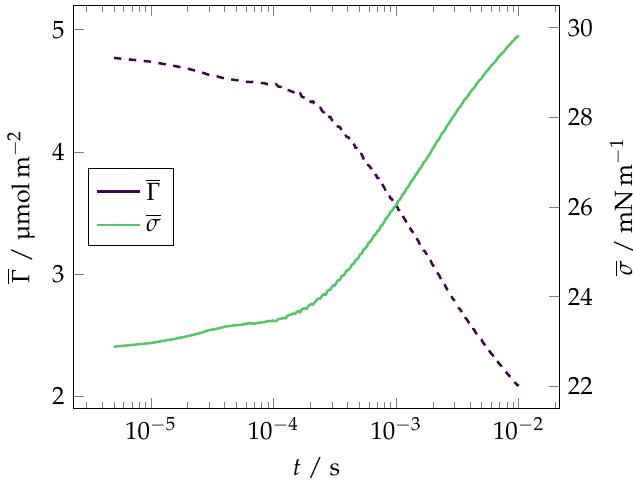
Figure 7. Mean surfactant concentration at the liquid-gas interface and mean surface tension during spreading of a droplet with insoluble surfactant. spreading of a droplet with insoluble